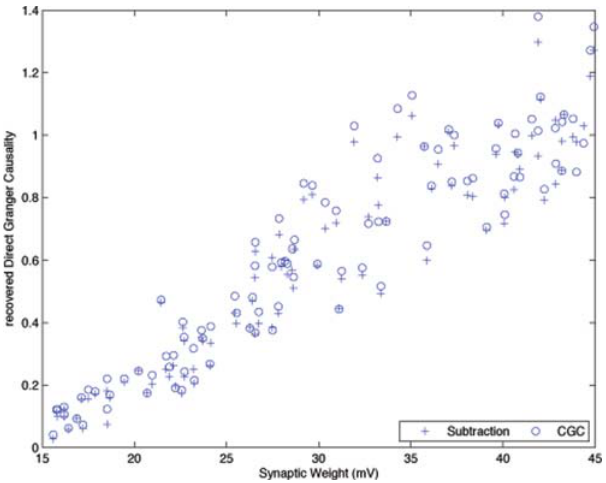
Figure 6. Comparison of Causality Values from a Traditional Conditional Granger Causality Analysis and the Computational Alternative Described in the Text. Direct influences between N2 and N3 were recovered by both methods to allow a comparison of Geweke’s subtraction method to CGC. Each point was generated from a Monte Carlo simulation of the serial simulation using randomly generated synaptic weights between 15 mV and 45 mV. This plot suggests that both methods provide results consistent with the linear region expected from the sigmoid plot shown in Figure 4. However, Geweke’s subtraction method is computationally simple providing the researcher with a clear advantage in large networks especially under conditions where the structural connectivity is known to be serially arranged.